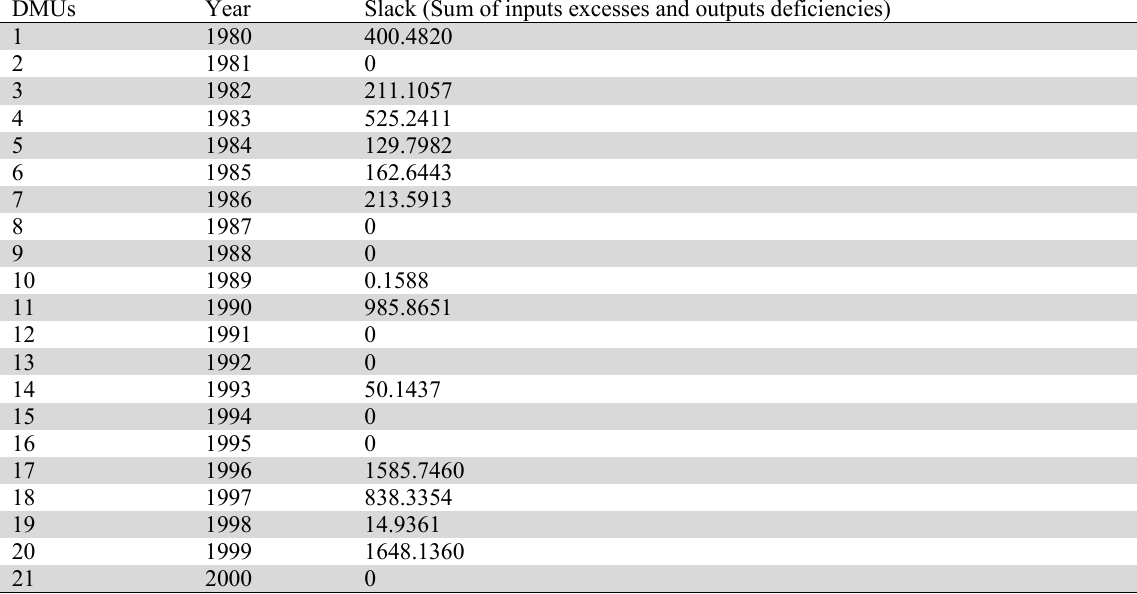
The results of the weighted additive CRS